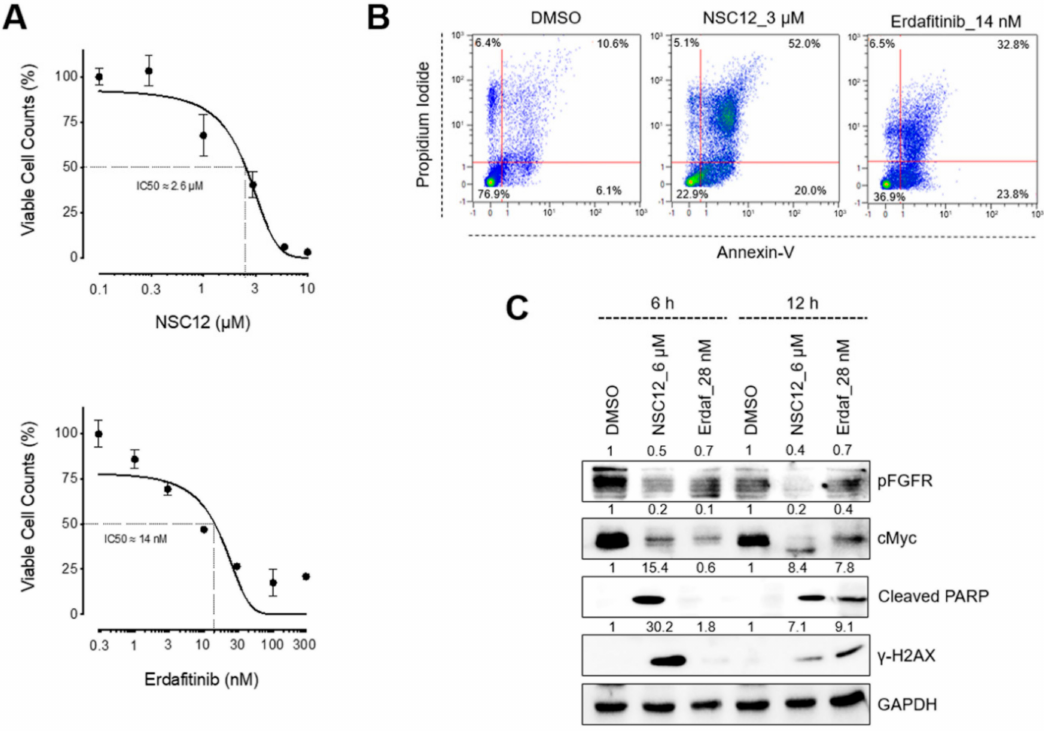
Figure 1. FGF (fibroblast growth factor) / FGFR (FGF receptor) inhibition induces apoptosis and DNA damage in FGF-dependent lung cancer cells. ( A ) H1581 viable cell counts by flow cytometric analysis 48 h after treatment with increasing doses of NSC12 or erdafitinib. Data are mean ± SEM of 3 or more experimental replicates. ( B ) Cytofluorimetric analysis of H1581 cell apoptosis by propidium iodide / Annexin-V double staining 48 h after treatment with NSC12 or erdafitinib. ( C ) Western blot analysis of H1581 cells after 6 and 12 h of treatment with NSC12 or erdafitinib. Densitometric quantification is reported above each